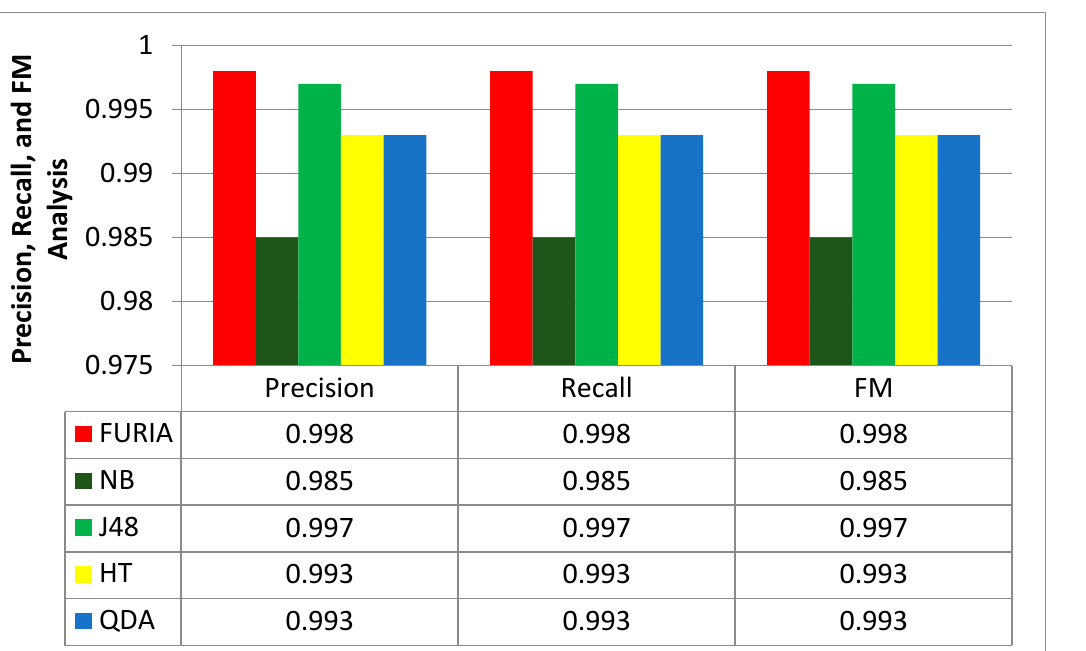
Figure 6. Accuracy analysis through each employed model. Here, “ln” is the natural logarithmic function, and a and b are constants in the equation. The following generic equations, which differ only in the most recent input, can be used to retrieve the constants: a = INDEX(cid:3435)LINEST(cid:3435)y, LN(x)(cid:3439), 1(cid:3439) (8) b = INDEX(LINEST(cid:3435)y, LN(x)(cid:3439), 1, 2)